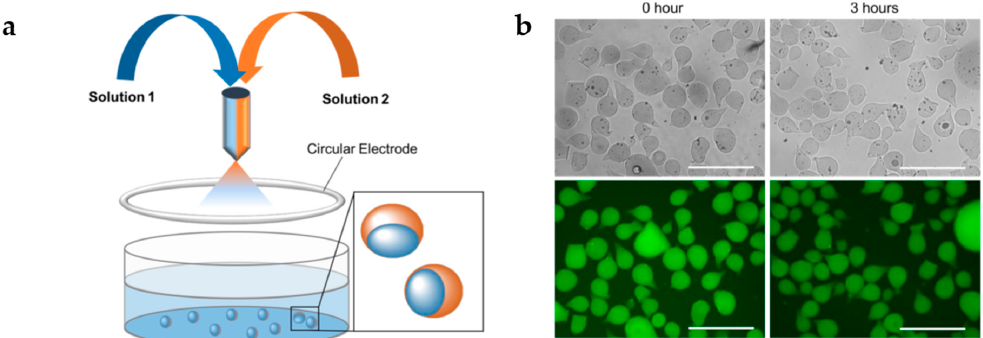
Figure 7. Fabrication of the alginate-based multi-compartment microgel beads with CdTe QDs incorporated: ( a ) Schematic diagram showing fabrication of multi-compartment microgel beads using the microfluidic electrospray technology; ( b ) Representative phase-contrast and fluorescence images of the QD-loaded microgel beads captured at different time points. The scale bar is 500 µ m (Reprinted with permission from [169]. Copyright 2016 American Chemical